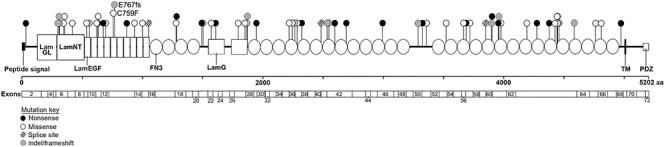
Position and type of USH2A variants in participating patients. Schematic diagram of the usherin protein domain architecture and USH2A exon structure. The genetic position and type of mutation of the identified USH2A variants in the patients within this study are presented as lollypops at the corresponding location in the usherin protein. Black labels correspond to nonsense mutations, white labels correspond to missense variants, diagonal lines correspond to splice site variants and grey labels correspond to insertion and deletion frameshift changes. LamGL, laminin globular-like domain; LamNT, N-terminal laminin domain; LamEGF, laminin-type epidermal growth factor-like domains; FN3, fibronectin III domains; TM, transmembrane domain; PDZ, PDZ-binding domain.